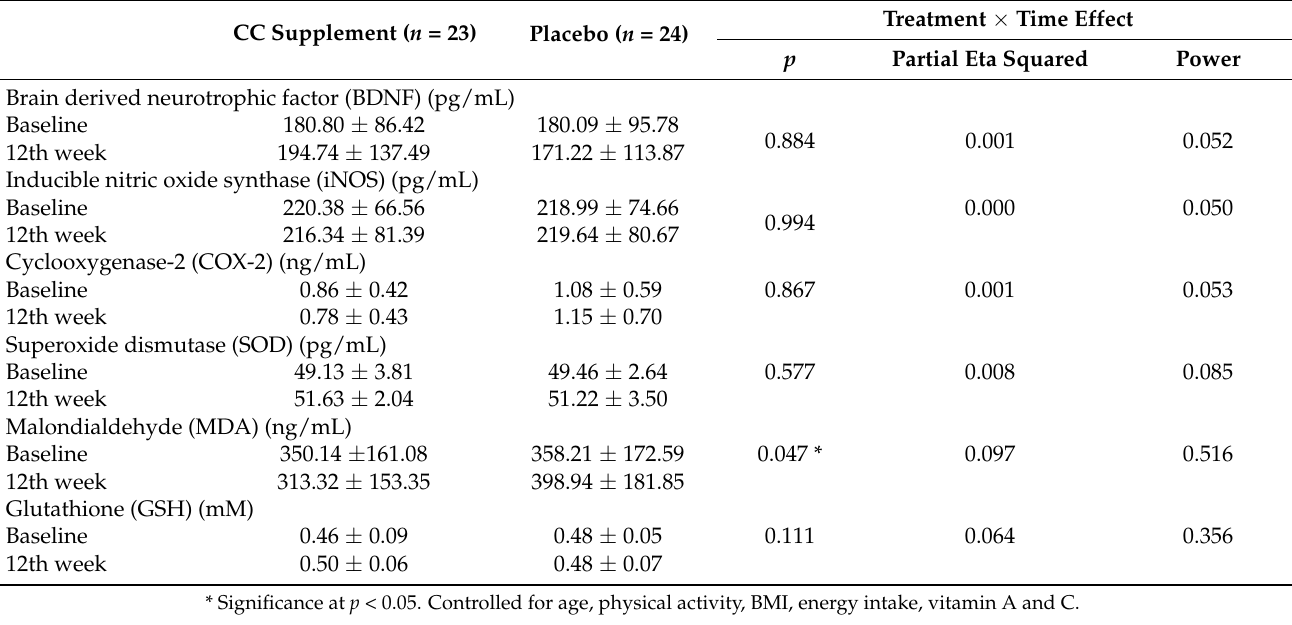
Table 5. Intervention effect of biomarkers from baseline to 12th week.